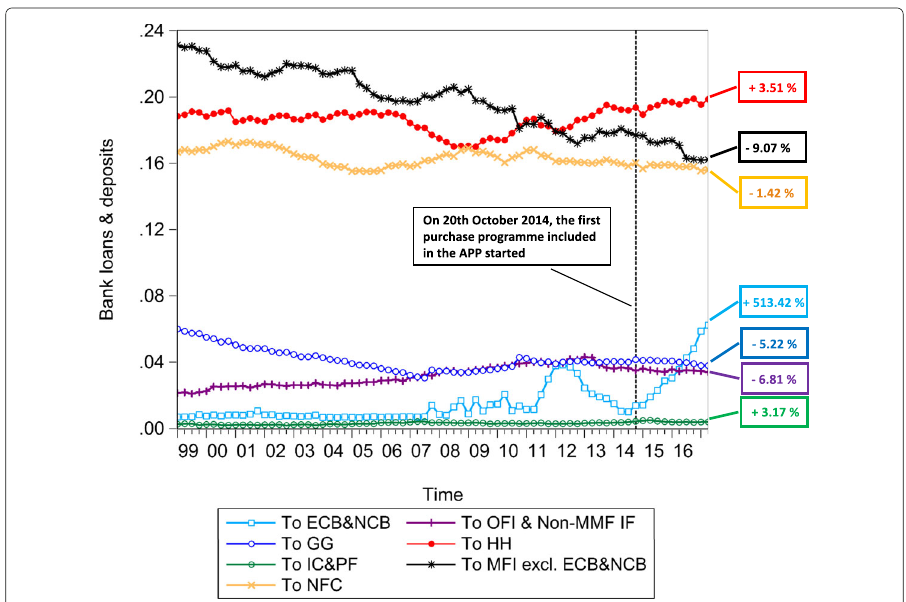
Fig. 12 Bank loan and deposit holdings - breakdown by counterparty sector; 1999Q1-2017Q2. Time series of the breakdown of loans and deposits granted by the euro area Monetary Financial Instutions excluding the Eurosystem by counterparty sector, i.e., Eurosystem (ECB&NCB, in light blue), Monetary Financial Institutions excluding the Eurosystem (MFI excl. ECB&NCB, in black), Other Financial Institutions and Non-MMF Investment Funds (OFI & Non-MMF IF, in purple), Insurance Corporations and Pension Funds (IC&PF, in green), Households (HH, in red), Non-Financial Corporations (NFC, in yellow), and General Governments (GG, in blue), over the reference period 1999Q1-2017Q2. The aforementioned time series are normalized by Monetary Financial Institutions excluding the Eurosystem total financial assets. The vertical dashed line corresponds to the beginning of the first purchase programme (3rd Covered Bond Purchase Programme, CBPP3) included in the APP, started in 2014Q4, while the percentages on the right-hand side of the graph correspond to our estimate of the growth rates of bank exposures in terms of loans and deposits to the different institutional sectors of the euro area, since the initiation of QE. Data source: (European Central Bank 2017b)